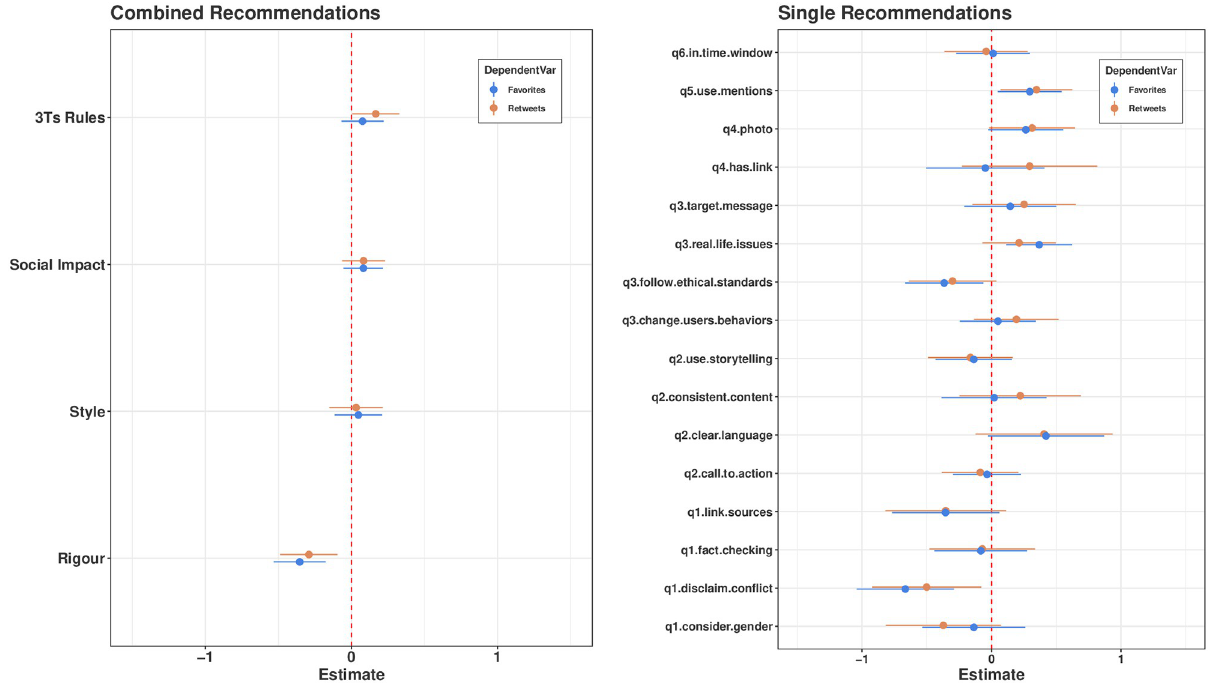
Fig 5. Point estimates and 95% confidence interval of negative-binomial regressions coefficients (Twitter). Left Panel: Coefficient estimates obtained by regressing favourites (in blue) and retweets (in red) on the number of recommendations adopted for each leading principle. Right panel: Coefficient estimates obtained by regressing favourites and retweets on each